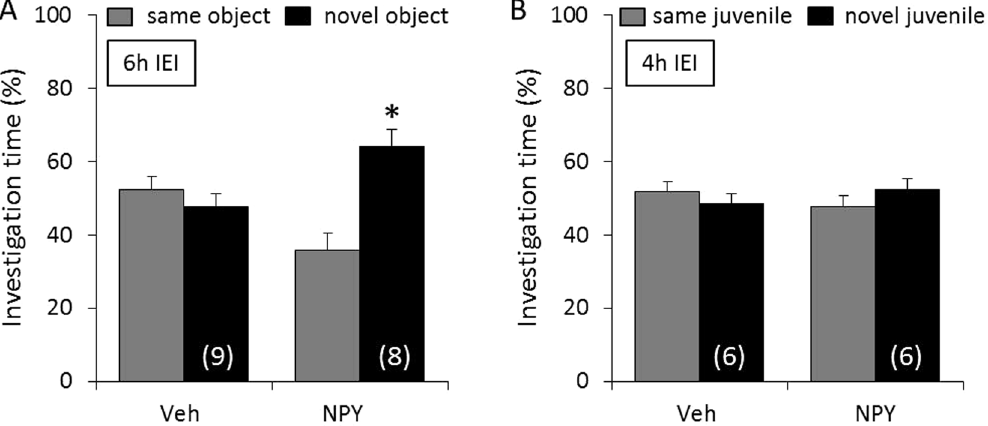
Figure 2. Neuropeptide Y (NPY) prolongs retention of non-social, but not of social, memory. Mice were infused icv with either vehicle (Veh; 2 µ l) or NPY (1 nmol/2 µ l) immediately after the acquisition period of the object ( A ) and social ( B ) discrimination test, respectively. Intact memory and discrimination abilities are reflected by an increased investigation of the novel versus the same stimulus after an inter-exposure interval (IEI) of 6 h ( A ) or 4 h ( B ). Data represent means + SEM, and numbers in parentheses indicate group sizes. * p < 0.05 versus same stimulus.